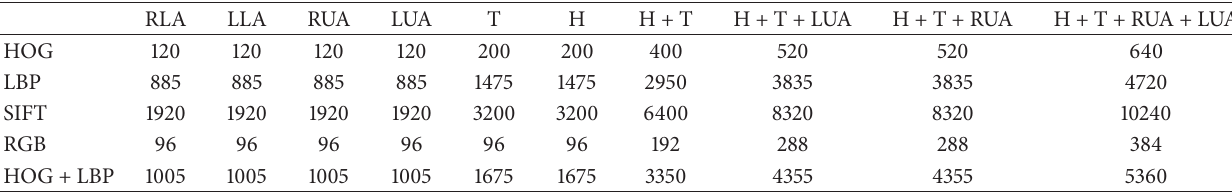
Table 6: Feature dimensions with various setups on PASCAL. No matter what the original dimensions are, the PLS method can efficiently reduce each number to a small value of 40 , which is very useful for real-time